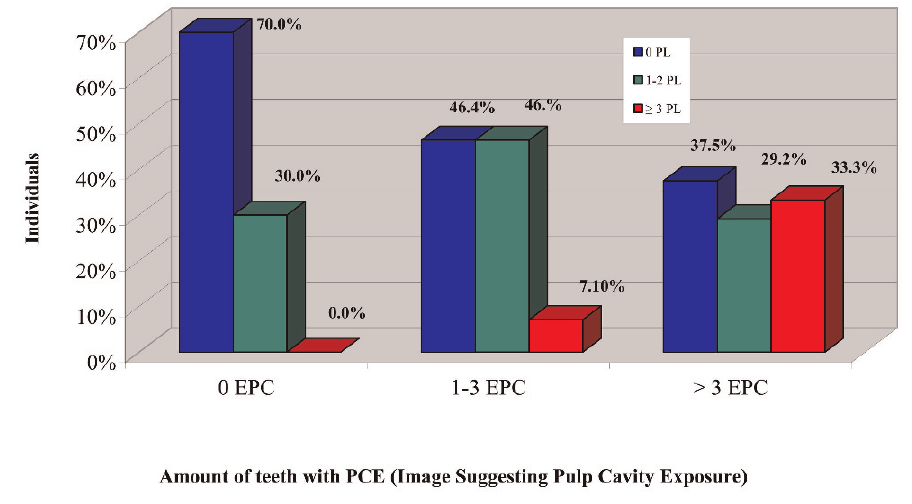
Figure 3 - Bivariate analysis between the number of teeth with images suggesting pulp cavity exposure (PCE) (categorized as 0, 1-3 and . 3) and the frequency (%) of individuals with periradicular lesions (PL) (categorized as 0, 1-2 and $ 3) ( p =0.002; Fisher’s exact